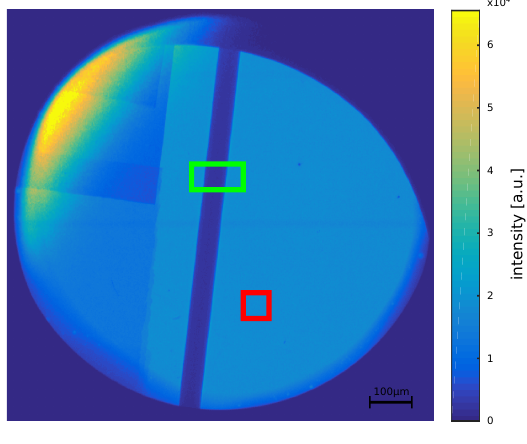
Figure 2. Measurement of a titanium wire with regions of interest (ROI). Green Rectangle : ROI that is used to reconstruct the wire. Red Rectangle :